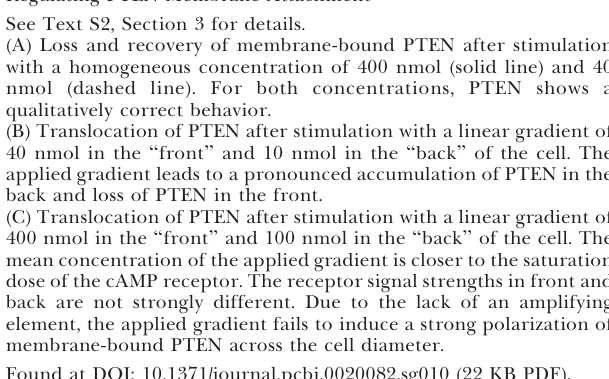
Figure S10. Behavior of PTEN with an Alternative Mechanism Regulating PTEN Membrane Attachment